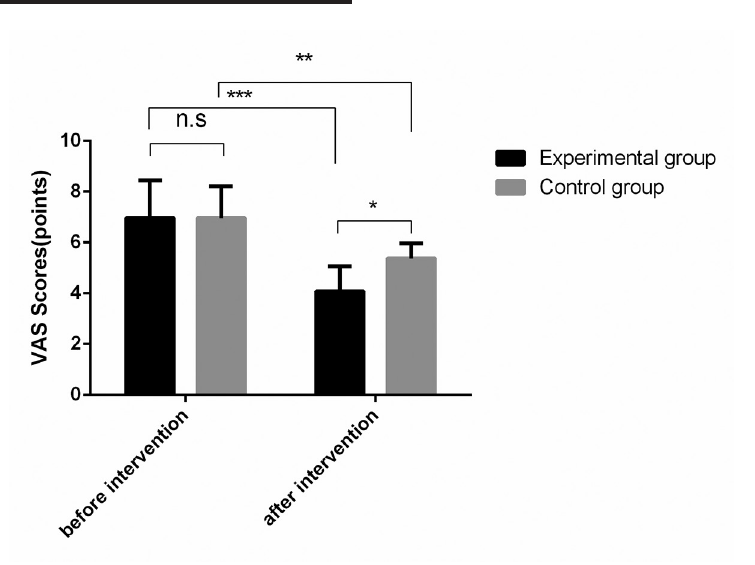
Figure 1. Between group comparison of VAS scores before and after intervention. Note : ***There were significant differences in VAS scores in the experimental group before and after intervention ( P < 0.001); **There were significant differences in VAS scores in the control group before and after intervention ( P < 0.01); *There were significant differences in VAS scores between the two groups after intervention ( P < 0.05); VAS, visual analog